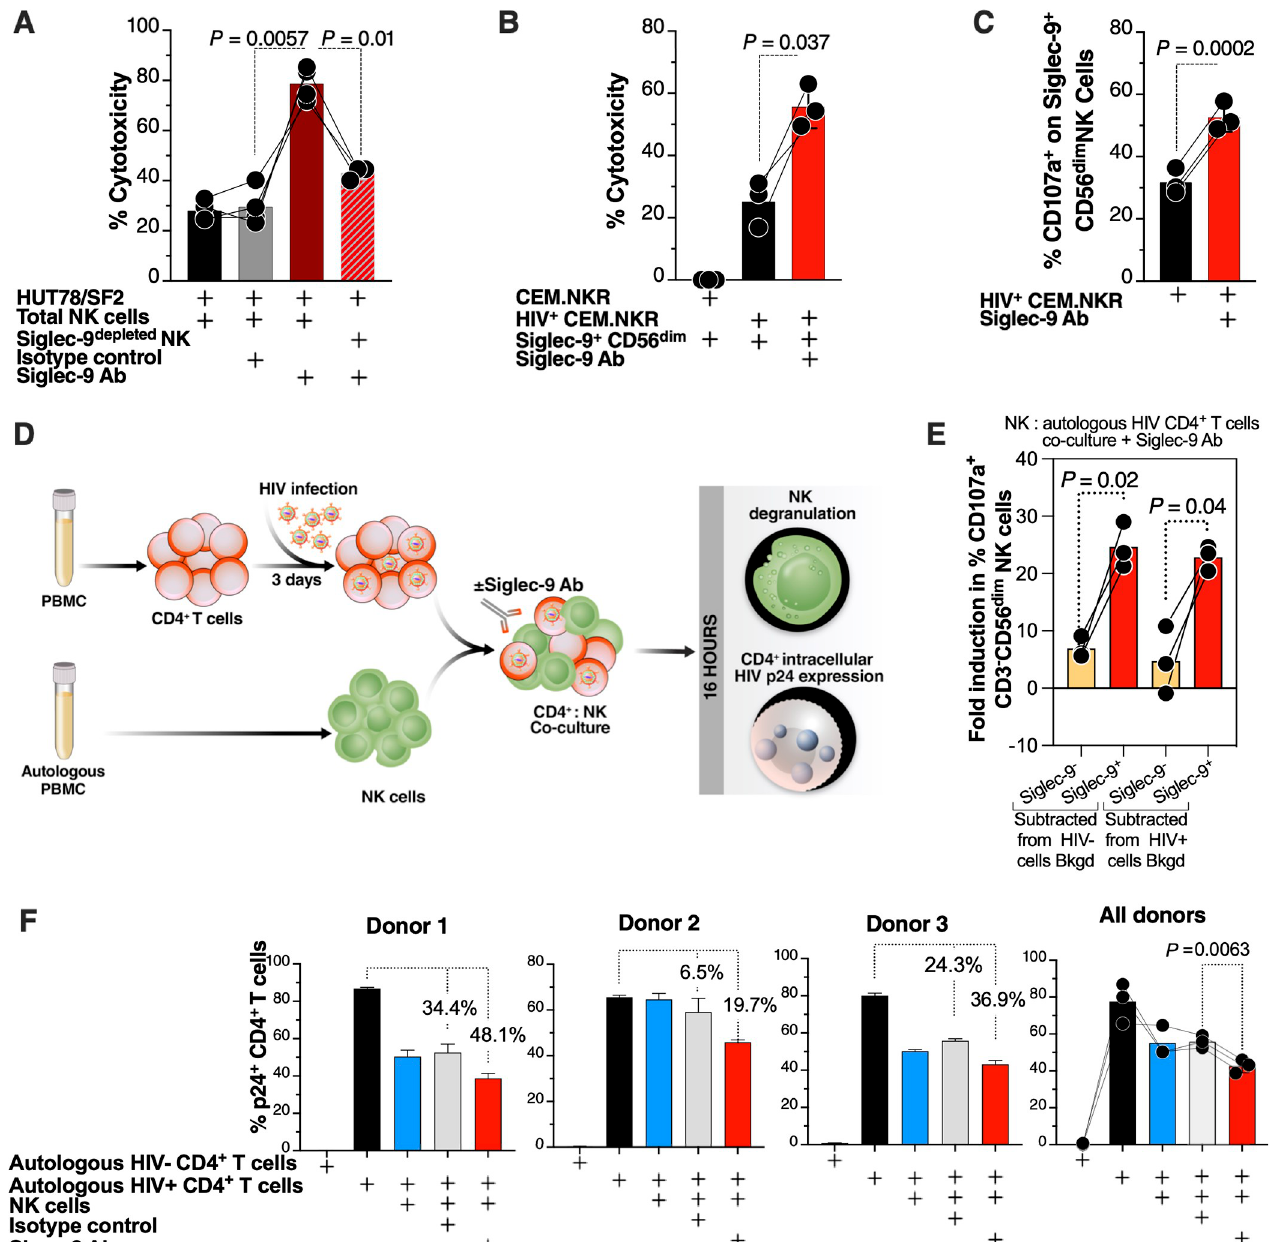
Fig 5. The cytotoxicity of Siglec-9 + CD56 dim NK cells towards HIV+ cells is being restrained by the inhibitory nature of the Siglec-9 molecule. (A) HIV- infected HUT78/SF2 cells were used as targets, and total or Siglec9 depleted NK cells from HIV-negative donors were used as effectors in the presence/absence of isotype control or Siglec-9 blocking Ab. Cytotoxicity was assessed by LDH release assay (E:T = 10:1). n = 4 donors (the last condition was performed on n = 3); assays from each donor were performed in 2–4 replicates, and the average of these replicates was used for statistical analysis using paired t-tests. (B-C) Blocking Siglec-9 enhanced the ability of Siglec-9 + CD56 dim NK cells to target HIV-infected CEM.NKR cells. Cytotoxicity was assessed by (B) the LDH release assay (E: T = 10:1) or (C) NK degranulation (E:T = 4:1). Analysis of NK degranulation was made on total NK cells gated on Siglec-9 + or Siglec-9 - CD56 dim NK cell subsets. n = 3 donors; assays from each donor were performed in 2–4 replicates, and the average was used for statistical analysis using paired t-tests. (D) A schematic representation of the workflow to evaluate effector NK degranulation and cytotoxic potential against autologous HIV-infected CD4 + T cells in the presence or absence of Siglec-9 Ab. CD4 + T cells were isolated from fresh PBMC and exposed to HIV-1 IIIB for 72 h. On the third day, effector NK cells were isolated from PBMC of the same donor and co-cultured with autologous HIV-infected CD4 + T cells in the presence or absence of Siglec-9 Ab for 16 h. Both NK degranulation and intracellular p24 expression were evaluated by flow cytometry. (E) NK degranulation (CD107a expression) from the experiment described in (D). Assay from each donor was performed in triplicate (E:T = 2.5:1; n = 3 donors). Bkgd = background. Statistical analysis was performed using Paired t-tests. (F) Intracellular p24 expression from the experiment described in (D). Assay from each donor was performed in triplicate wells (E:T = 10:1; n = 3